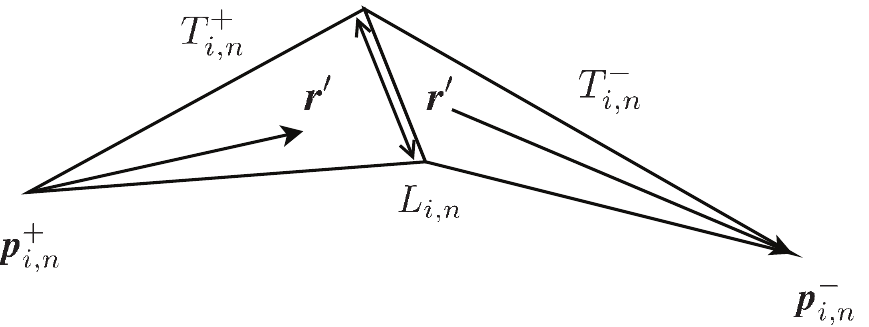
Figure 2. Spatial distribution of Rao–Wilton–Glisson (RWG)